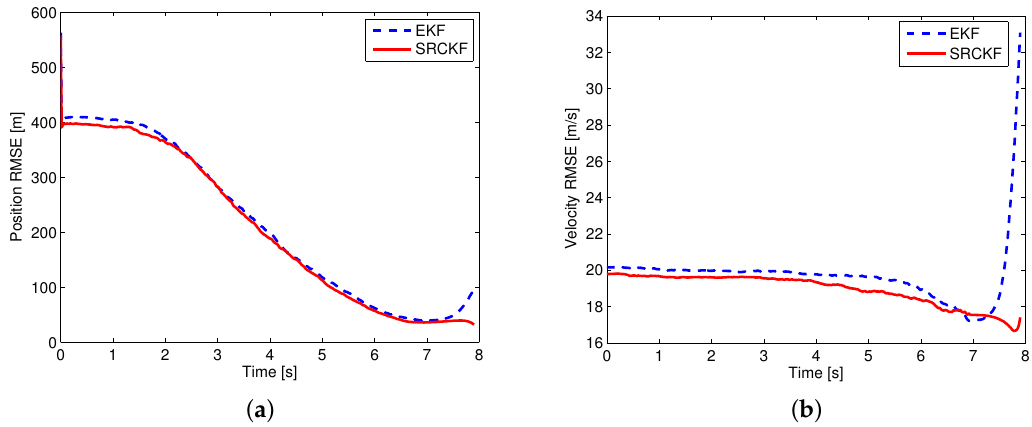
Figure 9. Estimation errors of the extended Kalman filter (EKF) and SRCKF: ( a ) position root-mean-square error (RMSE), ( b ) velocity RMSE.